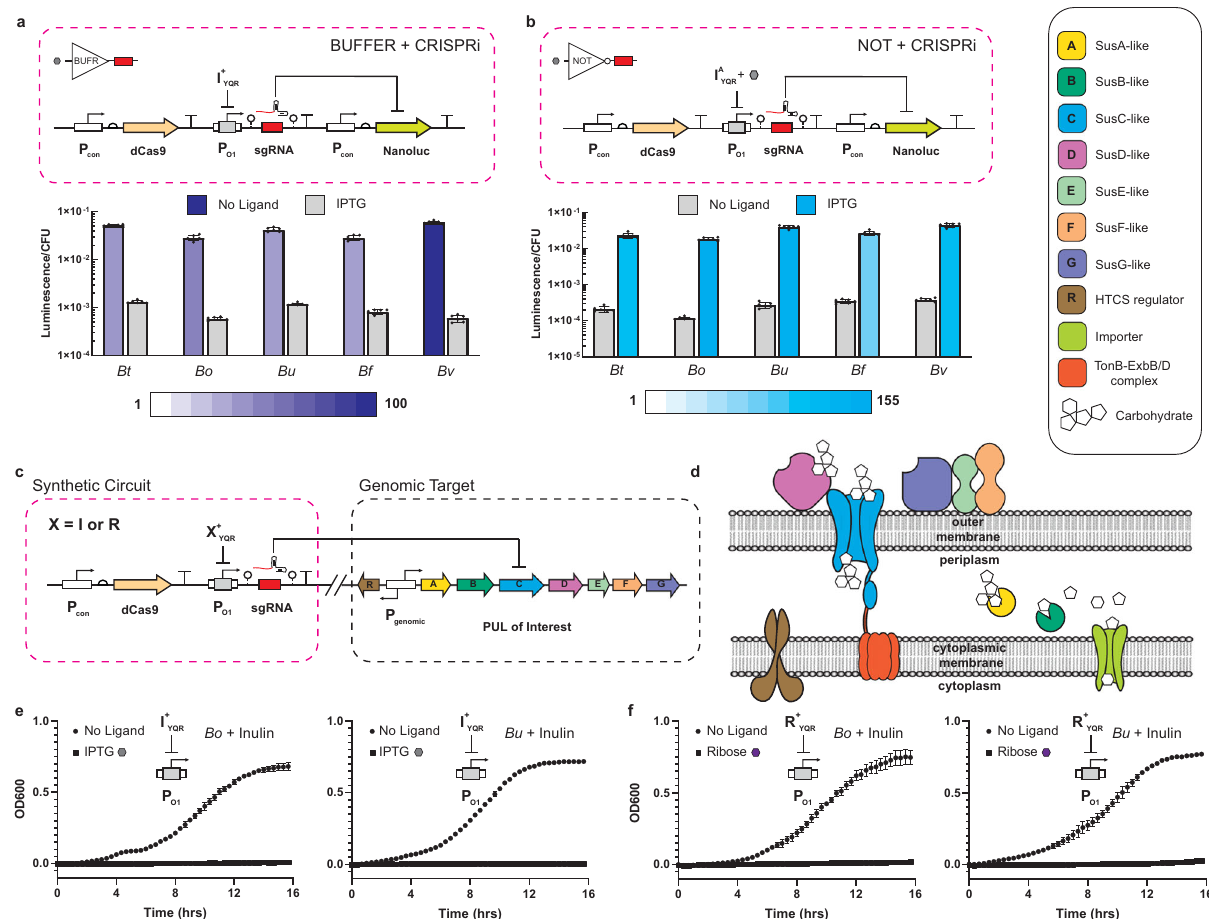
Fig. 4 Coupling transcriptional programming with CRISPR interference. a Wiring diagram for NanoLuc knockdown based on a BUFFER gate controlling a sgRNA (top). I + YQR was used to regulate a sgRNA targeting the NanoLuc gene. Strains harboring the circuit were grown in the absence and presence of 10 mM IPTG and assayed for luciferase activity (bottom) (Methods). Dynamic range is illustrated with shading according to the legend below the graph (purple representing anti-induction, blue representing induction) and is calculated as described previously. b Wiring diagram for NanoLuc knockdown based on a NOT gate controlling a sgRNA (top). I A YQR was used to regulate a sgRNA targeting the NanoLuc gene. Strains harboring the circuit were assayed as in a to determine performance (bottom). c Wiring diagram of CRISPRi circuit targeting endogenous SusC-like genes. Strains were created with X + YQR (X = I or R) regulating a sgRNA speci fi c to the SusC homolog of interest. d Cartoon of PUL organization, highlighting the function of the SusC-like importer. Colors of proteins and complexes correspond to the genes shown in c and are listed in the legend at the top right corner. e Growth curves of B. ovatus (left) and B. uniformis (right) harboring circuits shown in c with I + YQR as the sgRNA regulator. Strains harboring CRISPRi circuits were grown in the absence and presence of 10 mM IPTG in minimal media containing inulin as the only carbon source (Methods). f Similar to e , but the sgRNA regulator is now R + YQR . Strains harboring these circuits were grown in the absence and presence of 1 mM D-ribose in inulin minimal media. Source data are provided as a Source Data fi le. For luciferase assays, data represent the average of n = 6 biological replicates. For OD600 growth curves, data represent the average of n = 3 biological replicates. Error bars correspond to the SEM of these